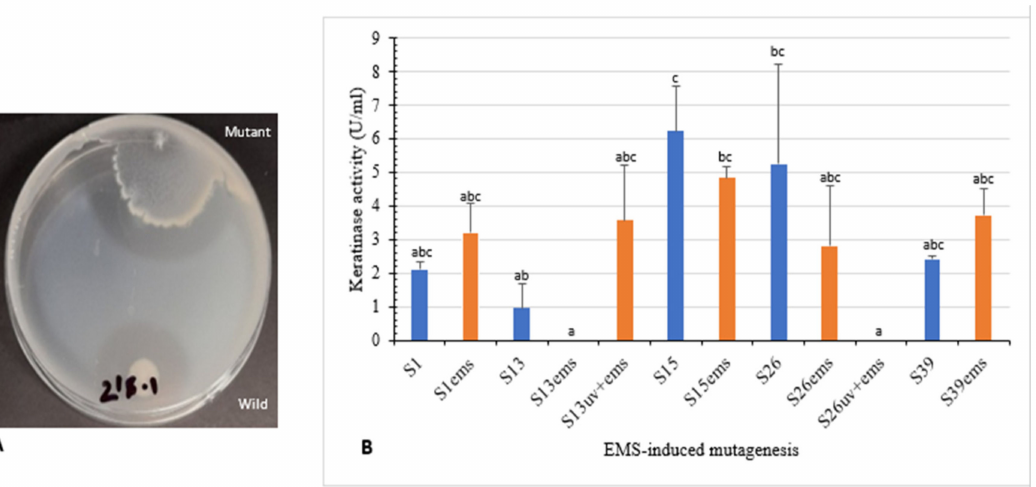
Figure 5. Effect of EMS-random mutagenesis on keratinase activity. ( A ) Wild and EMS-mutated isolate S39 showing clear zone of hydrolysis on skim milk agar. ( B ) Keratinolytic activity of wild, EMS and UV+EMS-mutated isolates. Bars are the standard error of the mean. Mean with the different letters are significantly different according to Duncan’s at p <